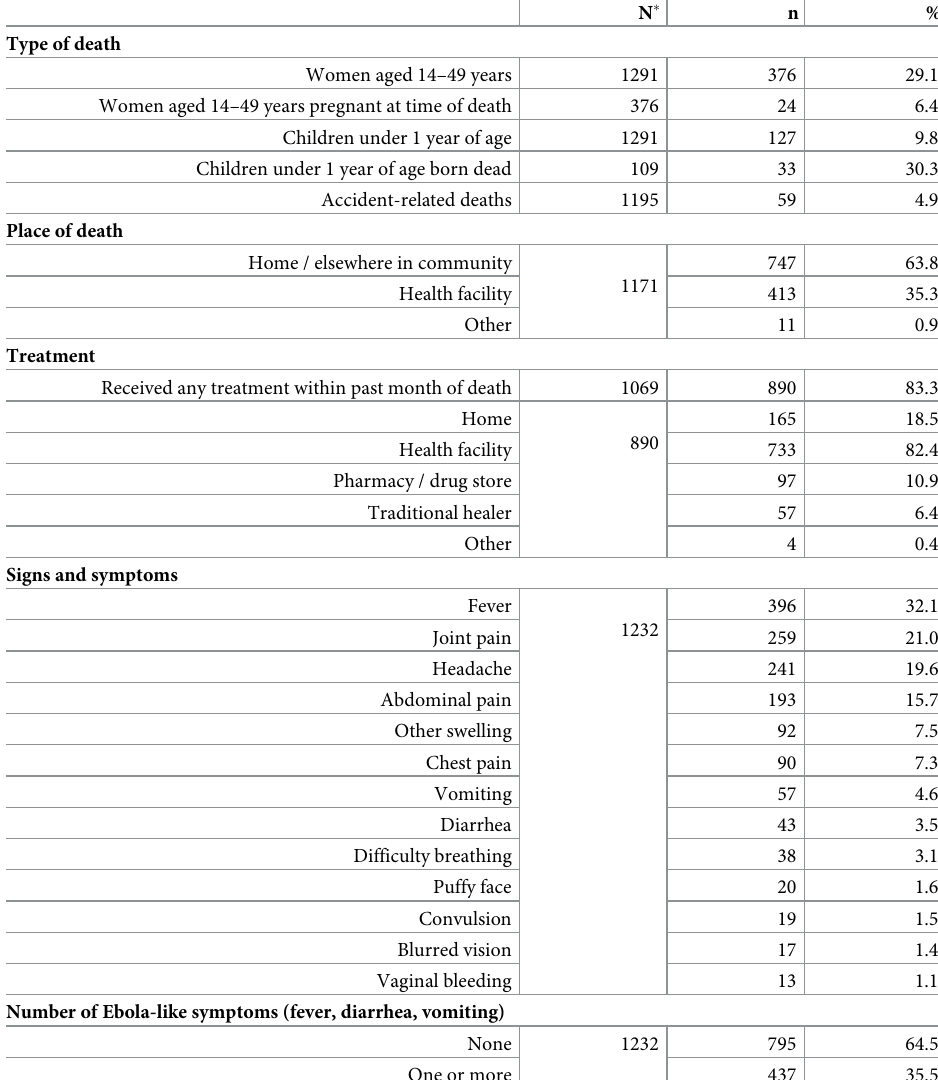
Table 3. Circumstances of the deaths reported in the sample, Sierra Leone, April